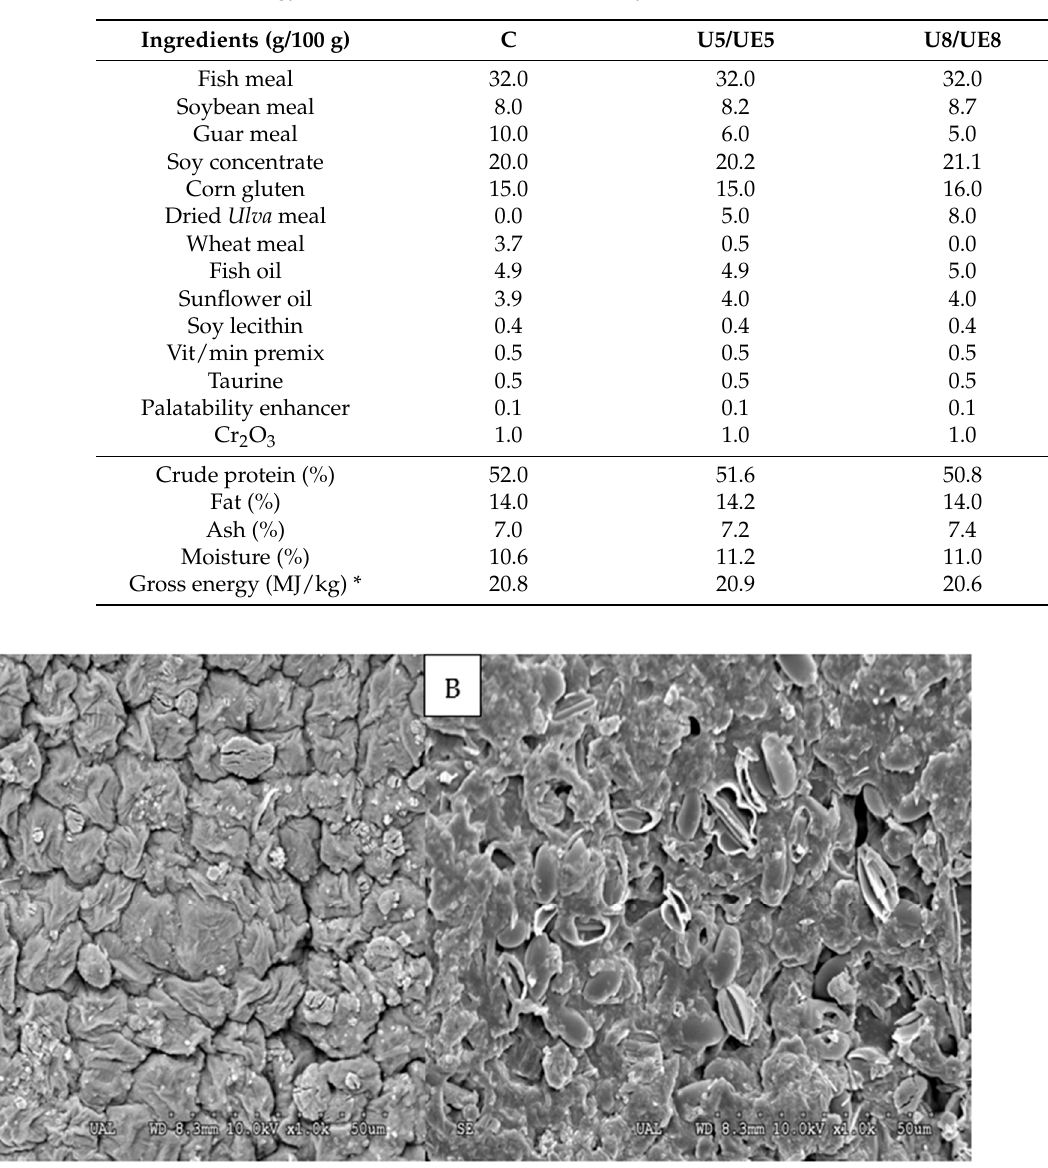
Figure 2. Scanning electron microscopy of a sample of the meal of Ulva ohnoi ( A ) before enzymatic hydrolysis and ( B ) after 24 h of enzymatic hydrolysis.